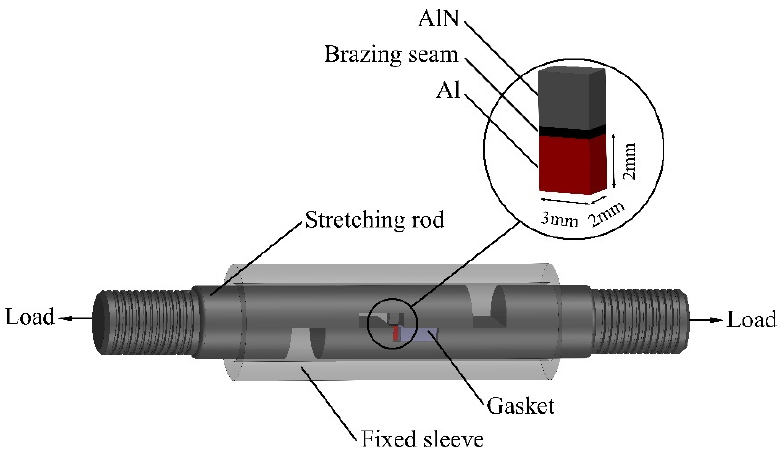
Figure 4. Schematic diagram of the shear strength fixture for AlN/Al brazed joints.